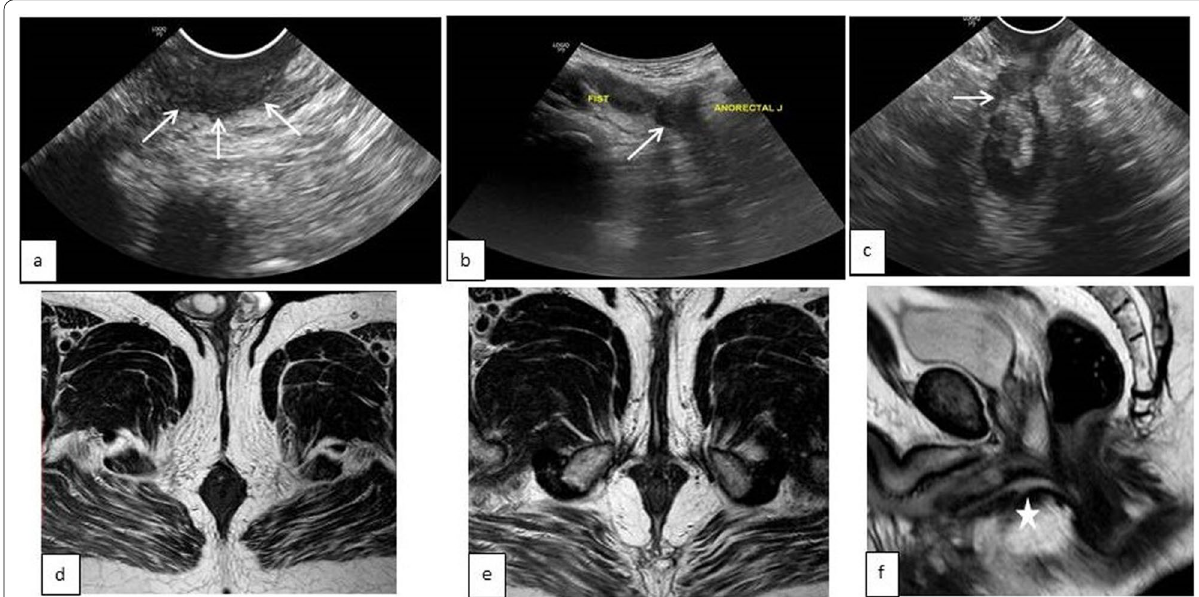
Fig. 2 A 50‑year‑old male patient presenting with recurrent high perianal fistula. TPUS with saline injection through the skin opening shows the external opening at the scrotal skin ( a ), sagittal plane shows the fistula joining the anal canal at the anterior aspect of the ano‑rectal junction ( b ), leading to the internal opening at 12 o’clock ( c ). In oblique axial MRI T2WI ( d , e ), the internal opening is seen breaching the proximal part of the deep external anal sphincter to reach the anal canal ( d ) without breaching the puborectalis muscle ( e ). In sagittal T2 MR image ( f ), the tract is seen breaching the anal canal anteriorly. A small side branch is seen emerging from the under surface of the tract can be seen which was not detected by TPUS